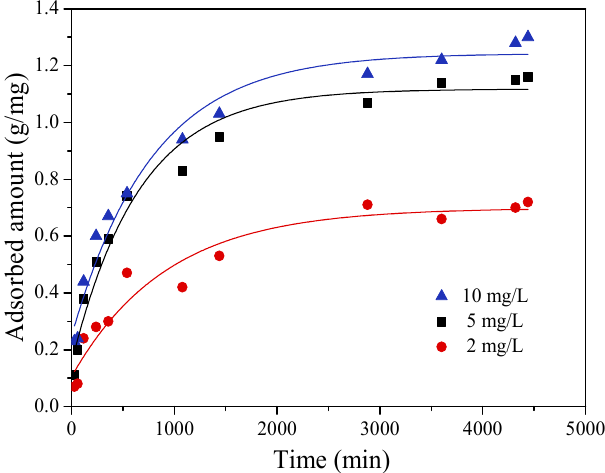
Figure 10. Adsorption dynamic curve of fluoride on MnOOH-supported AA. Figure 11 presents the kinetic curves of fluoride with initial concentrations of 2, 5 and 10 mg/L for adsorption on MnOOH-supported AA. The correlation coefficients ( R 2 ) were 0.8060, 0.9764 and 0.9632 as evaluated by the quasi-first-order model (Figure 11a). According to the quasi-second-order model, the R 2 values were 0.9862, 0.9978 and 0.9956, respectively (Figure 11b). It could be discovered that the experimental data perfectly fitted with the quasi-second-order equation. The results demonstrated that the quasi-second- order model could describe the entire defluoridation process, which was in accordance with previous studies [20,27,31]. During the adsorption process, some fluoride passed through the orifice and diffused into the pores of MnOOH-supported AA, which was described as physical adsorption. Some other fluoride was adsorbed owing to the fluoride– hydroxyl exchange reaction, which was chemical adsorption. Therefore, the adsorption process of fluoride was composed of physical adsorption and chemical adsorption, and chemical adsorption played the dominant role. In general, the entire defluoridation kinetics of MnOOH-supported AA were better fitted by the quasi-second-order model [32,33], including external diffusion, inner diffusion, and surface adsorption, etc.